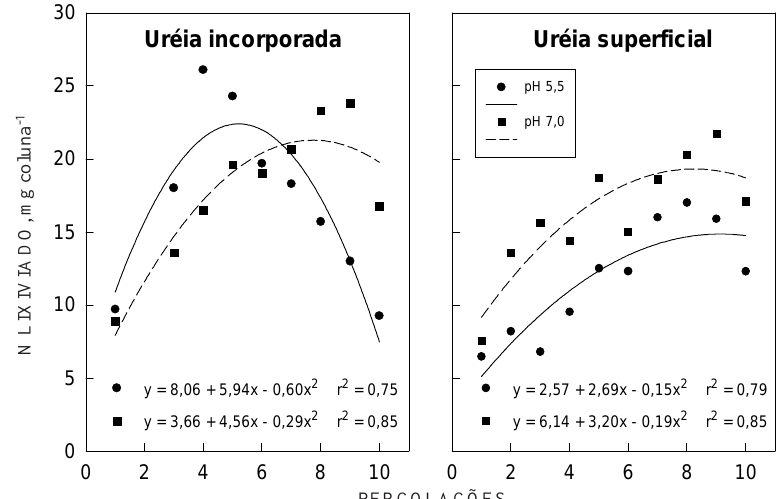
Figura 1. Nitrogênio total lixiviado em cada uma das dez percolações de água destilada, considerando o pH e o método de aplicação da uréia num Nitossolo